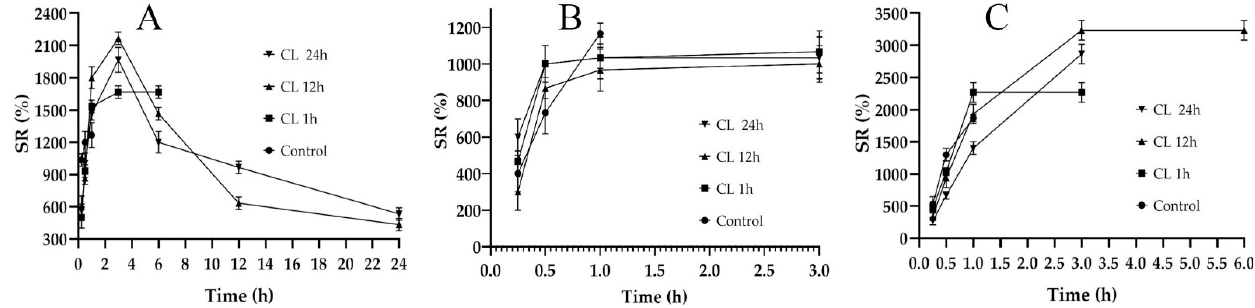
Figure 2. Swelling studies of the non-crosslinked (Control) and crosslinked (CL) films for 1, 12, and 24 h immersion. ( A ) F 1 C 1 , ( B ) F 1.5 C 0.5, and ( C ) C 1.5 F 0.5 . Data presented as mean ± SD.